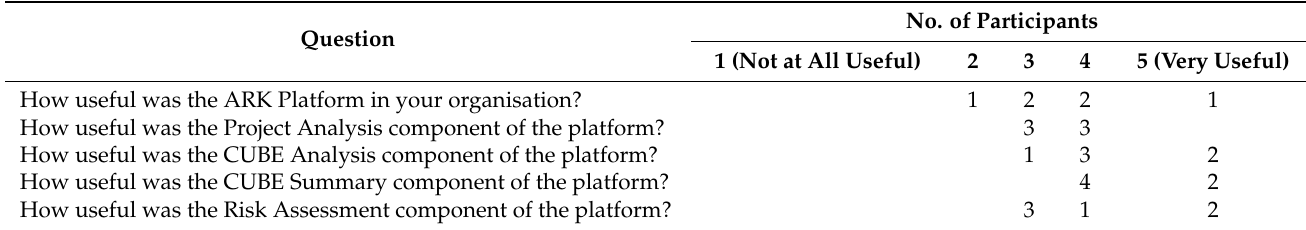
Table 2. ARK platform